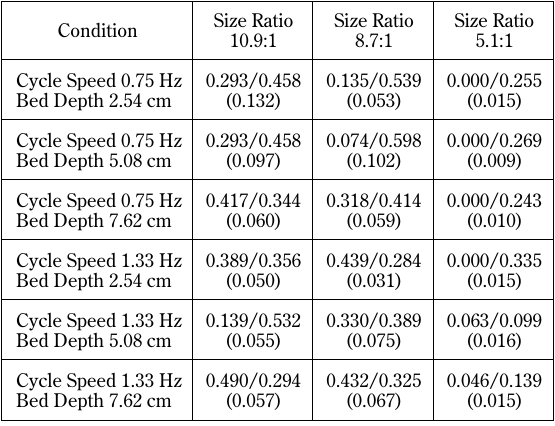
Table 4 Convective-diffusive segregation constitutive model para- meter values ( µ / δ ) at 15% strain with standard deviations between data and model in parentheses